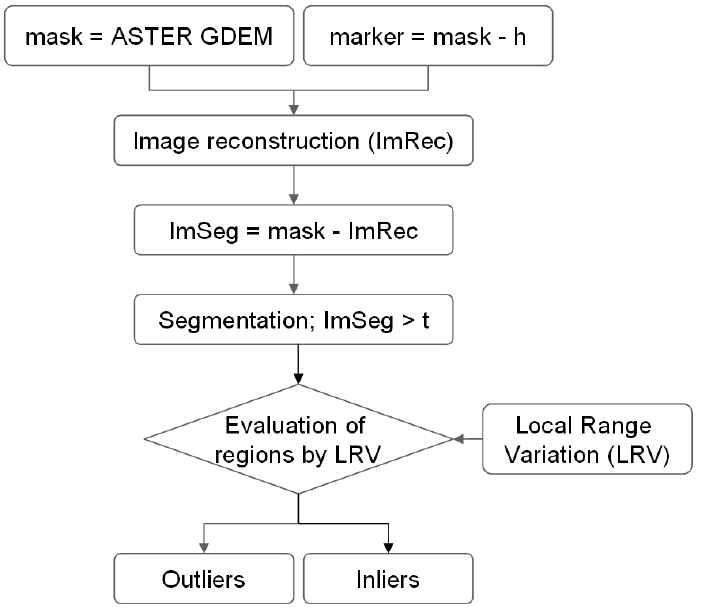
Figure 7. Proposed workflow for extracting positive